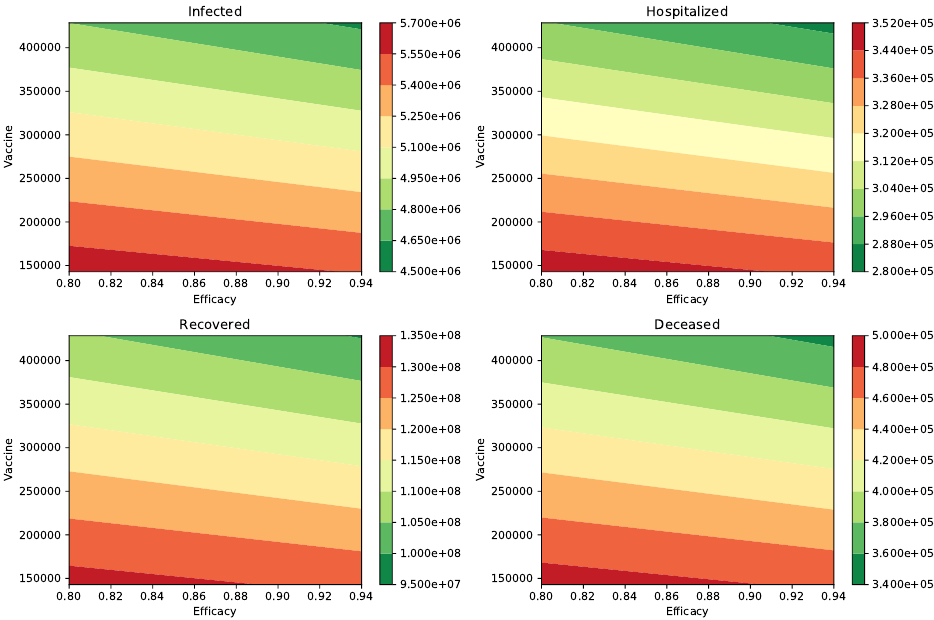
Figure 4. Impact of the inoculation rate and efficacy of the vaccine on the peak of the infected (I) and hospitalized (H) subpopulations. In addition, on the deaths (D) and recovered (R) cases. In these scenarios, the infectiousness of the asymptomatic individuals relative to symptomatic is 100% ( β A = β I ), and the percentage of infections that are asymptomatic is 40%. In all these scenarios the transmission rate is β =